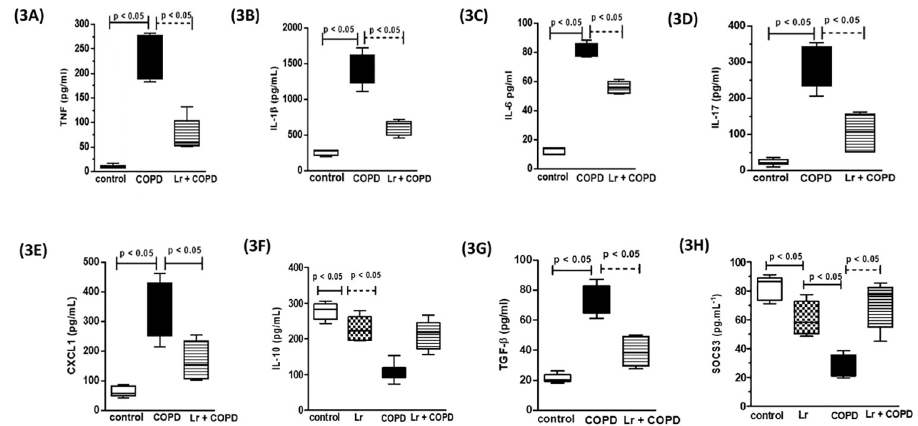
Fig 3. Cytokines and chemokines in BALF and SOCS3 in lung tissue. The BALF obtained from control, COPD, and Lr + COPD groups was prepared for analysis of pro- and anti-inflammatory cytokines. The mediator’s TNF (3A), IL- 1 β (3B), IL-6 (3C), IL-17 (3D), CXCL1 (3E), IL-10 (3F), TGF- β (3G) in BALF and SOCS3 (3H) in lung tissue were assayed by enzyme-linked immunosorbent assay (ELISA). Each plot represents mean ± SEM from 7 different animals. The experiments were performed in triplicate. Results were considered significant when p < 0.05.